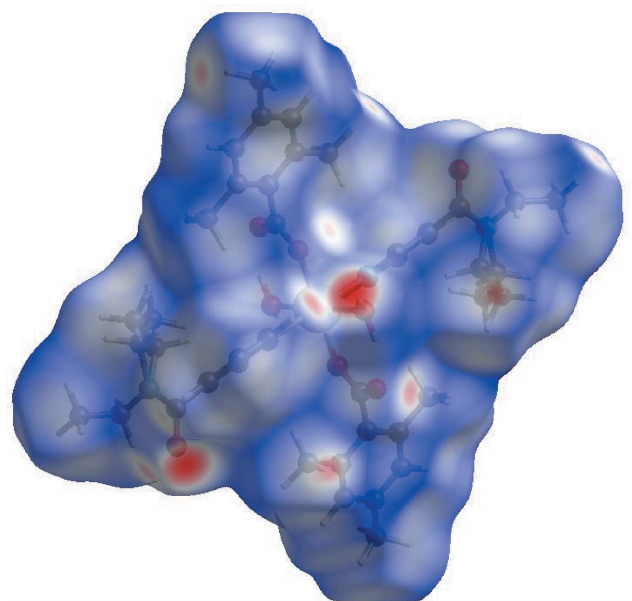
Figure 3 View of the three-dimensional Hirshfeld surface of the title complex plotted over d norm in the range (cid:4) 0.6741 to 1.6440 a.u.